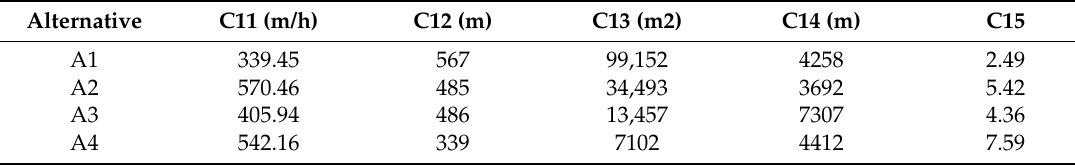
Figure 3. Distribution and general situation of the four sites. Table 2. Performance numerical values of the first type sub-criteria.